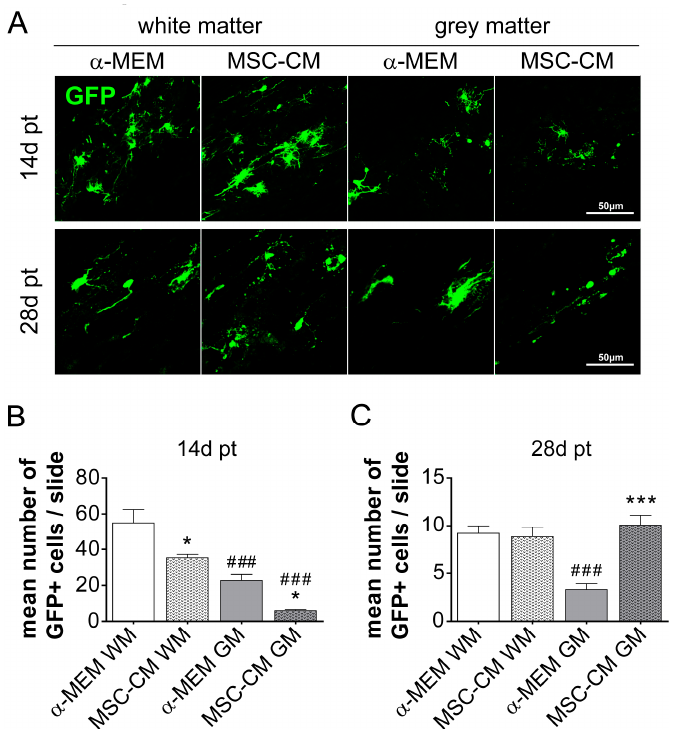
Figure 3. Survival rate of rat aNSCs after transplantation into the rat spinal cord. ( A ) Representative images of GFP-positive transplanted cells 14 and 28 days post-transplantation (pt) either in white or grey matter of the rat spinal cord. Corresponding quantifications of GFP-positive cells per slide (a mean of three sections per slide) and animal in white and grey matter at 14 days ( B ) and 28 days ( C ). Statistical significance was calculated using a two-way ANOVA with Bonferroni posttest: * p ≤ 0.05, *** p ≤ 0.001 (for comparison between control α -MEM to MSC-CM) and ### p ≤ 0.001 (for comparison between white and grey matter and respective transplantation paradigm). Animal numbers ( n ): 14 days pt α -MEM n = 4 and MSC-CM n = 5, 28 days pt α -MEM n = 6 and MSC-CM n =